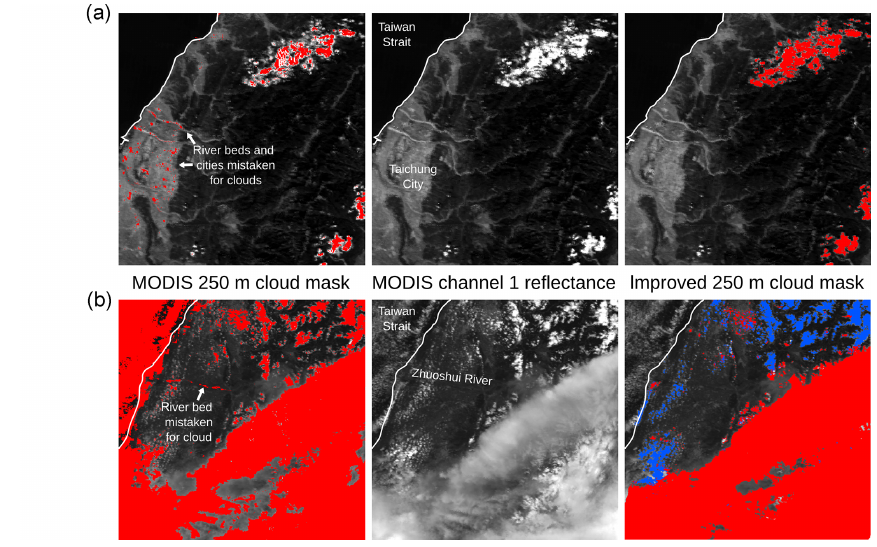
Figure 8. Comparison of the MODIS 250m cloud mask and the improved 250m cloud mask for MODIS overflights over Taiwan on (a) 25 January 2014, 10:10UTC + 8, and (b) 9 June 2014, 10:20UTC + 8. The colors in (b) represent ice clouds (red) and water clouds (blue). The improved cloud mask is only calculated for land